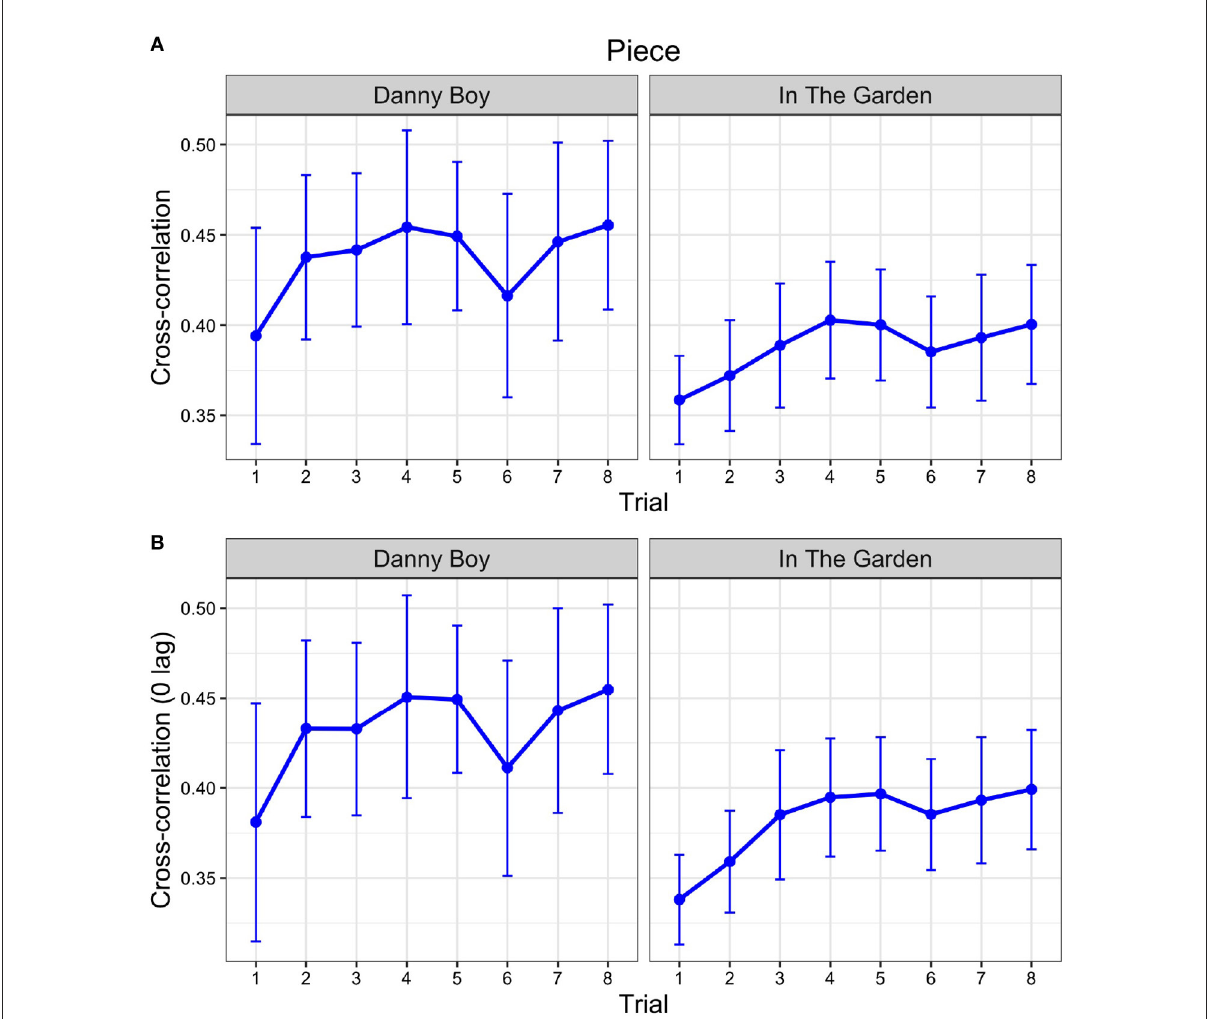
FIGURE4 Cross-correlation (CC) values for each piece separately across the eight trials. (A) Similarity, calculated using the maximum CC value on each trial for lags between − 1.25 and +1.25 s. (B) Synchrony, calculated using a lag of 0